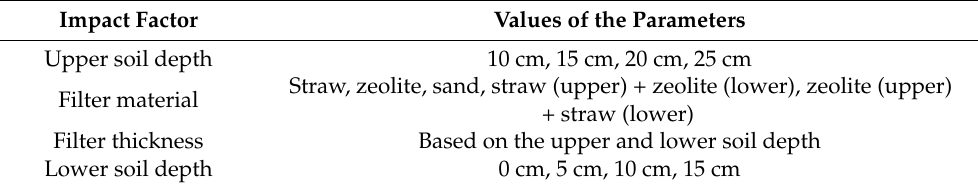
Table 6. Value of simulation parameters in different situations.